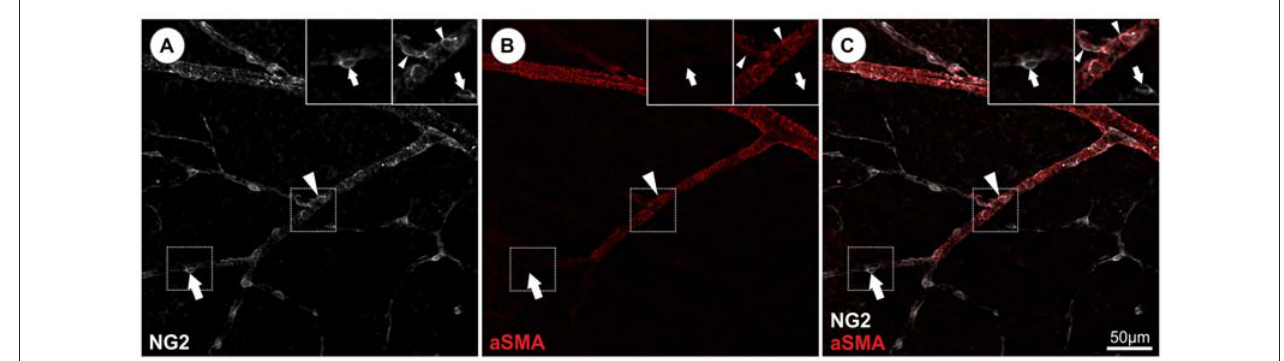
FIGURE 2 | Identification and discrimination of pericytes from vascular smooth muscle cells (vSMCs) in the retina visualizing NG2 and alpha smooth muscle actin (aSMA) protein expression. (A) NG2 immunopositivity can be detected in both, retinal pericytes (representative arrow) and aSMA positive arteriolar SMCs (representative arrowhead). (B) Retinal capillary pericytes lack the aSMA signal (arrows) and (C) can be therefore discriminated from vSMCs as illustrated in the merged picture (in accordance with results in Trost et al., 2013).